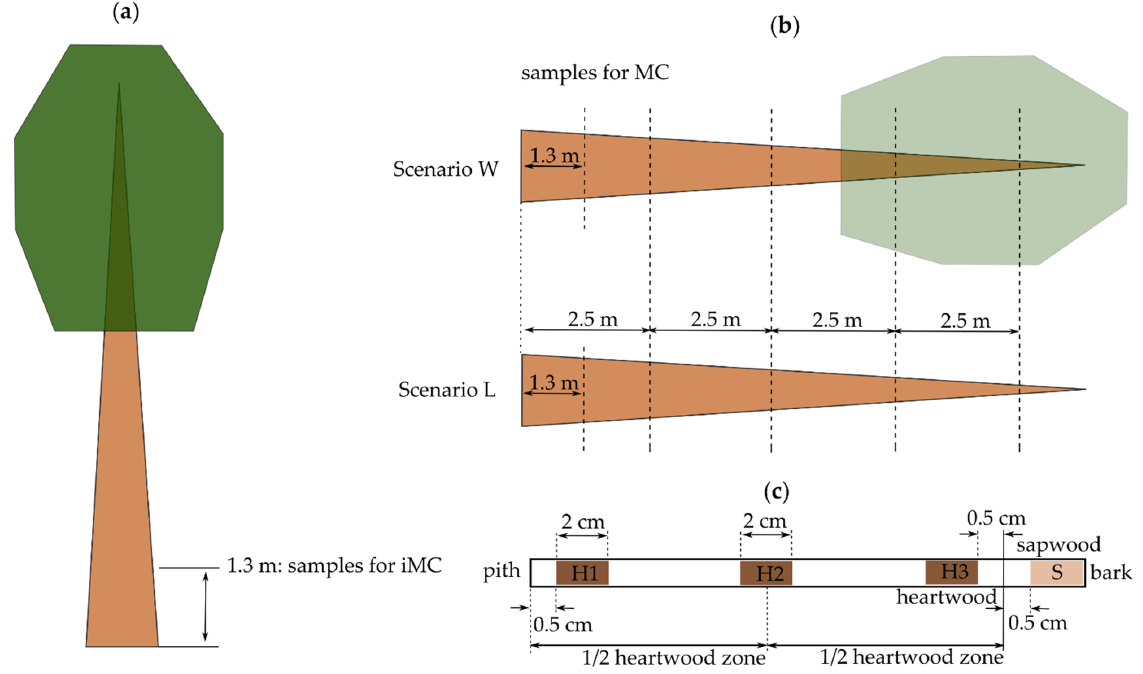
Figure 1. Schematic visualization of the process wood sampling: ( a ) for initial moisture content; ( b ) for scenarios; ( c ) on trunk cross ‐ section.